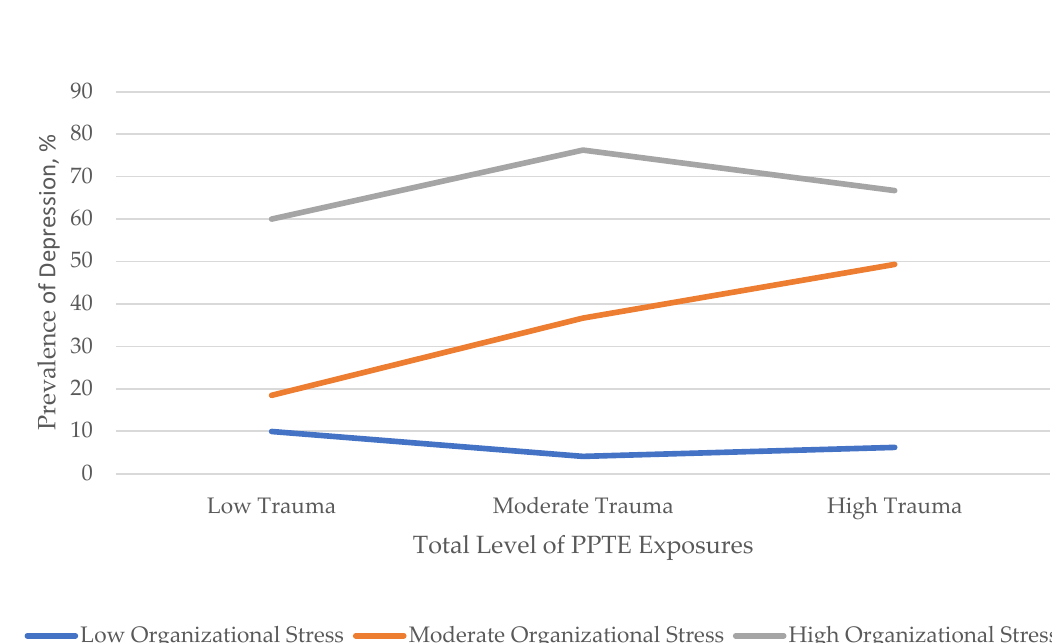
Figure 1. Interaction of Total Trauma by Organizational Stress on Major Depressive Disorder Symptoms. Notes . Low trauma exposure and low organizational stress were defined as scores less than 1 standard deviation below their respective means; moderate trauma exposure and moderate organizational stress were defined as scores ranging from 1 standard deviation below the mean and 1 standard deviation above the mean; high levels of trauma exposure and high organizational stress were defined as scores more than 1 standard deviation above their respective